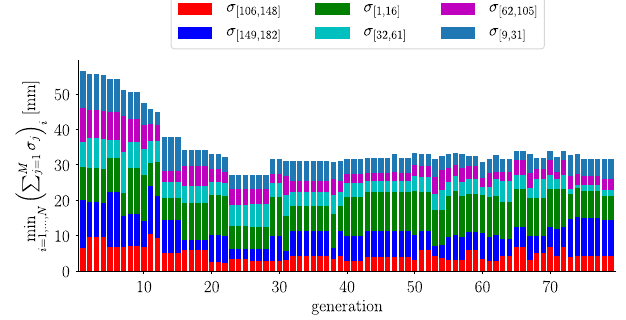
FIG. 17. Evolution of the best individual during the multi- objective optimization. The best individual of a generation is identified by the smallest sum of objectives σ and M the number of objectives. The best individual was contained first in generation 26. The minimization is over all N ¼ 8062 individuals per generation. The label σ ½ objective for the turns in the range ½ l; u (cid:2) .